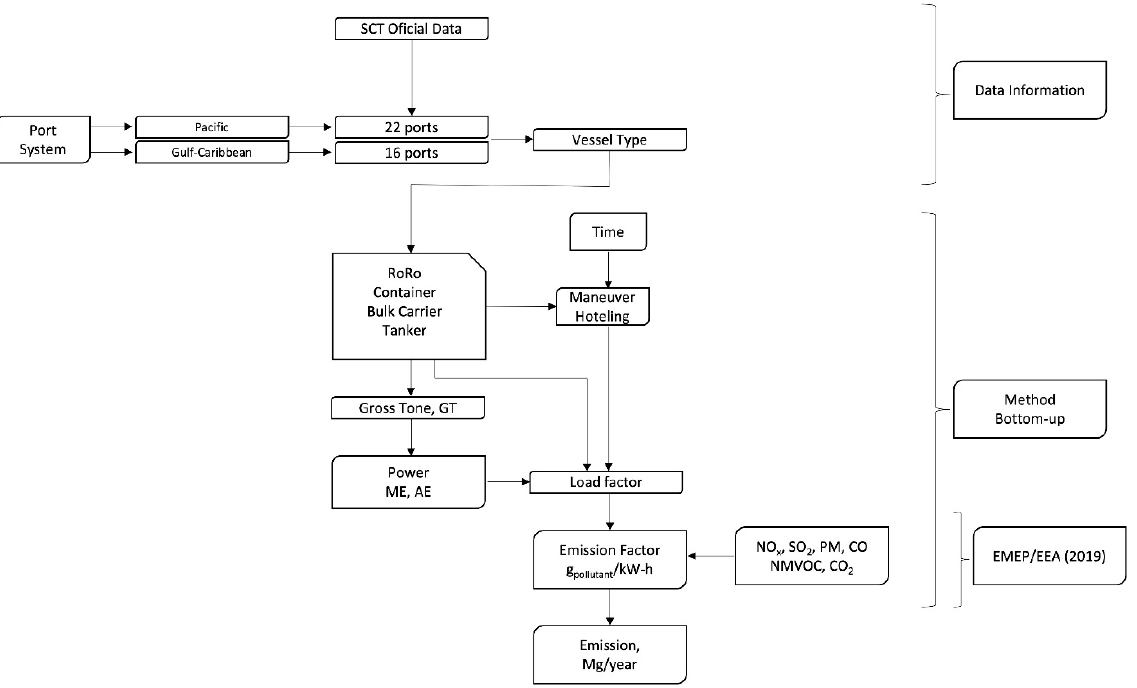
Figure 2. Information required to estimate atmospheric emissions in Mexico.